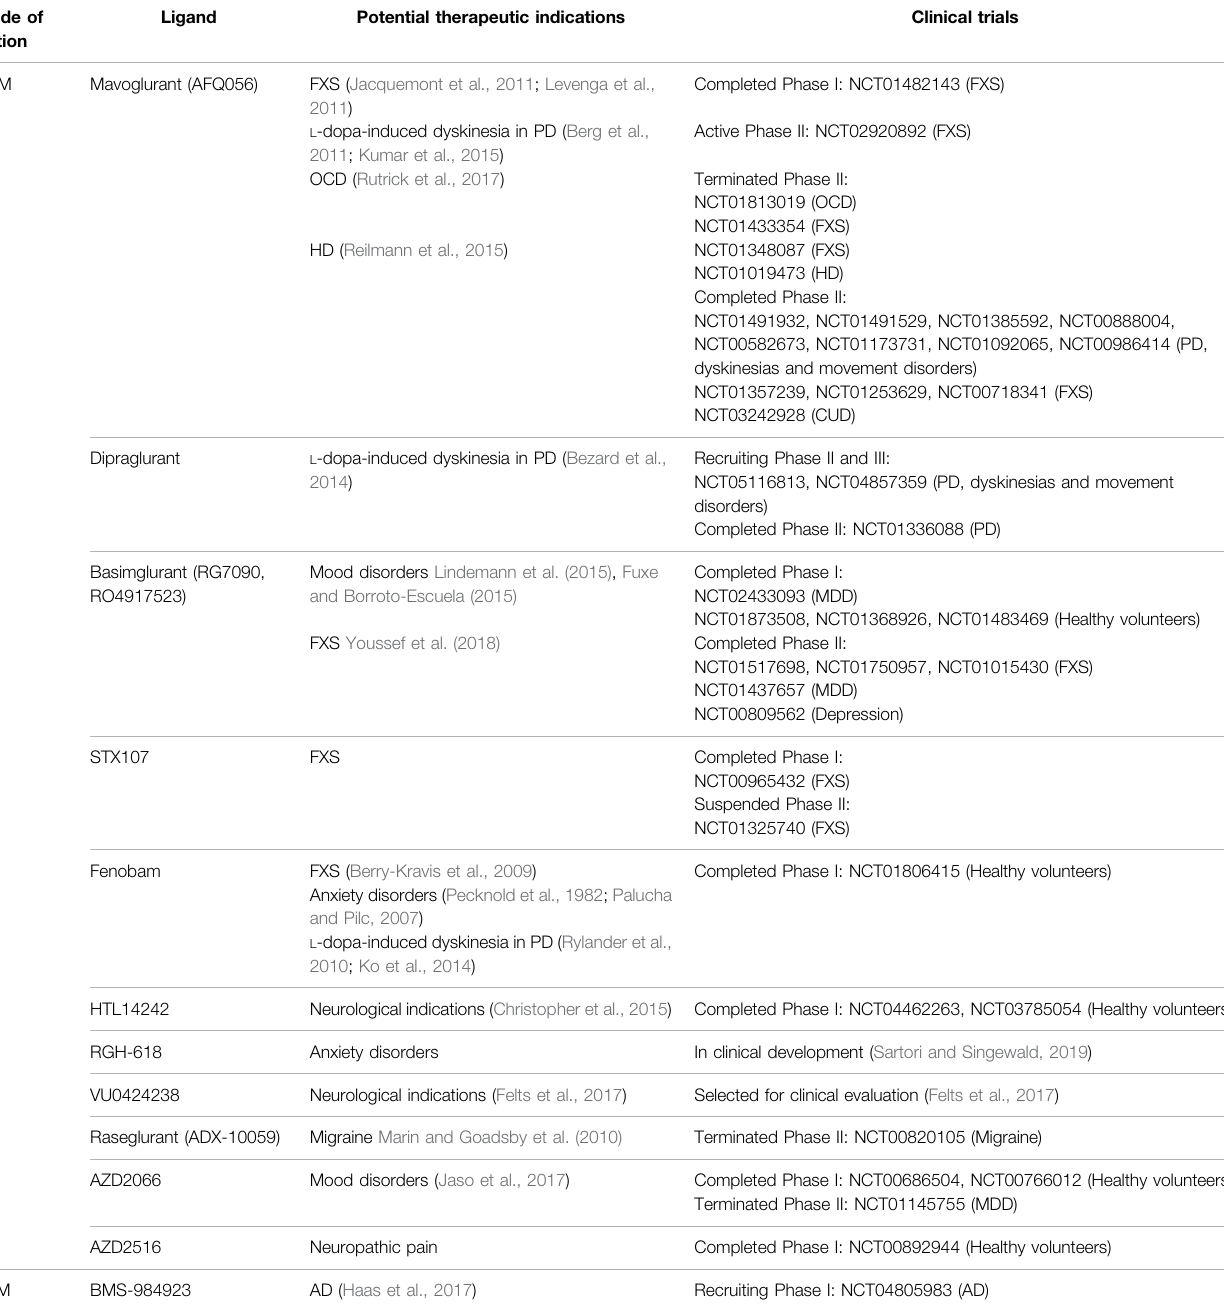
TABLE 1 | Allosteric modulators of mGlu 5 that have entered clinical trials for neurodegenerative and neurological disorders. All clinical trials found at www.clinicaltrials.gov. For detailed in vitro pharmacological characterization of clinically tested mGlu 5 NAMs see Arsova et al. (2020). Mode of